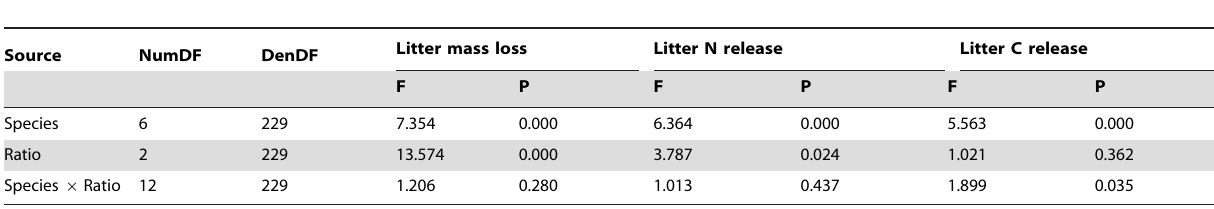
Table 2. Analyses of litter mixing effects for litter mass loss and nutrient release were performed by mixed effect model with mixture type (species) and mixing ratio as fixed effects and decay time as a random